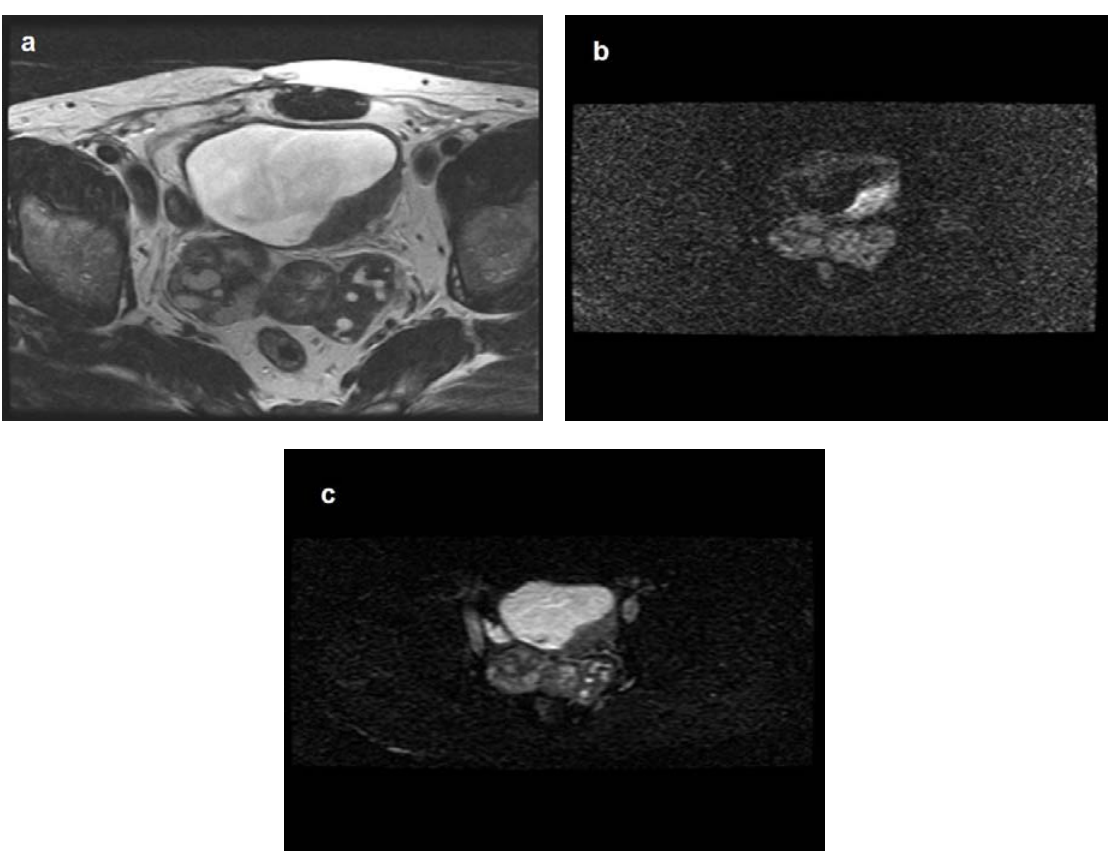
FIGURE 1 . (a) Axial high-resolution T 2 -weighted MRI of urinary bladder showing a nodular growth at the posterior aspect of left lateral wall with enlarged seminal vesicles. (b) DW MRI showing the mass with high SI. (c) ADC map showing the mass with low